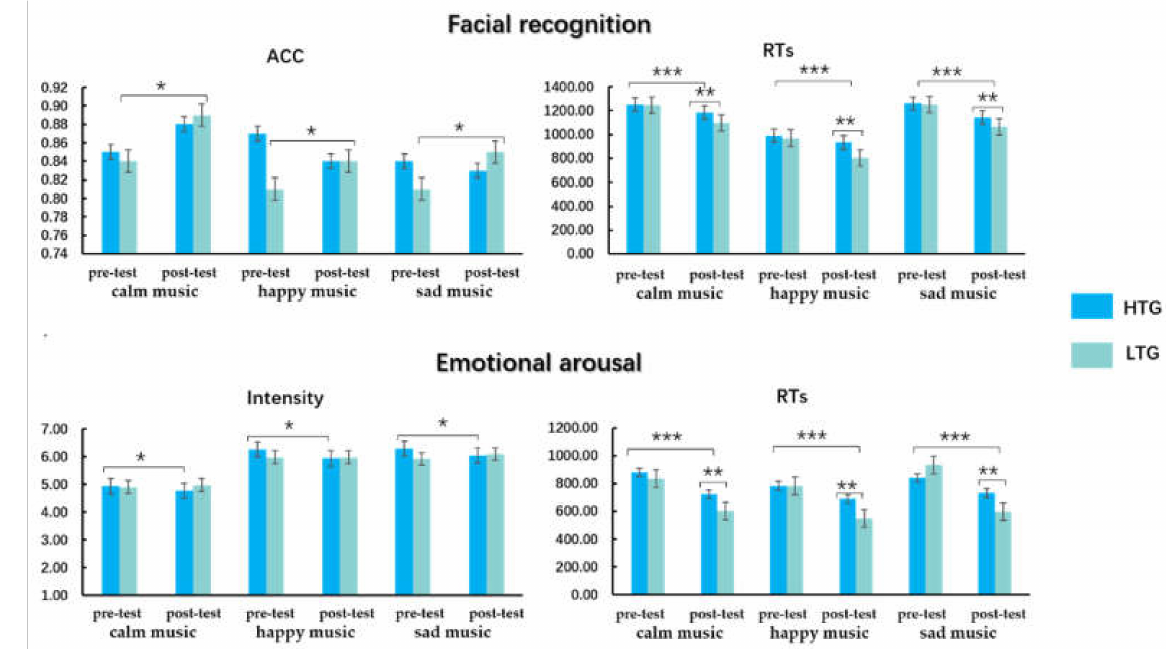
Figure 3. Accuracy (ACC) and reaction times (RTs) difference within-group and between-group in the facial recognition and emotional arousal task; HTG: high trait group, LTG: low trait group; * p < 0.05, ** p < 0.01, *** p <